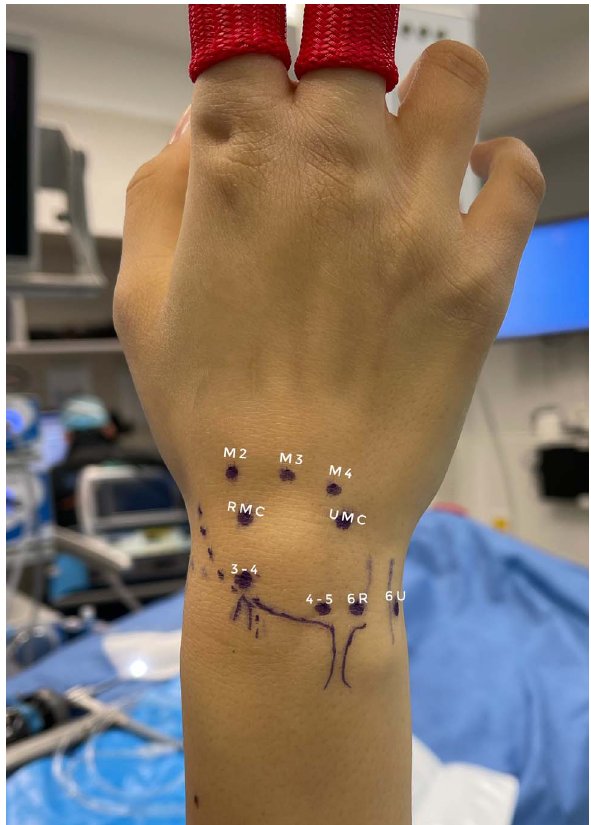
Figure 2. Classic portals in wrist arthroscopy. 3 – 4 portal is usually the fi rst portal to be opened. It lays on the soft spot, 1 cm distal to the Lister ’ s tubercle, between the third and fourth extensor compart- ments. 4 – 5 portal is located between the fourth and fi fth extensor compartments. 6R and 6 U portals are radial and ulnar to the sixth extensor compartment, respectively. The RMC portal lays distal to the 3 – 4 portal in the axis of the basis of the second metacarpal, whereas the UMC portal lays distal to the 4 – 5 portal in the direction of the basis of the fourth metacarpal. RMC, Radial Mid-Carpal; UMC, Ulnar Mid-Carpal (m);